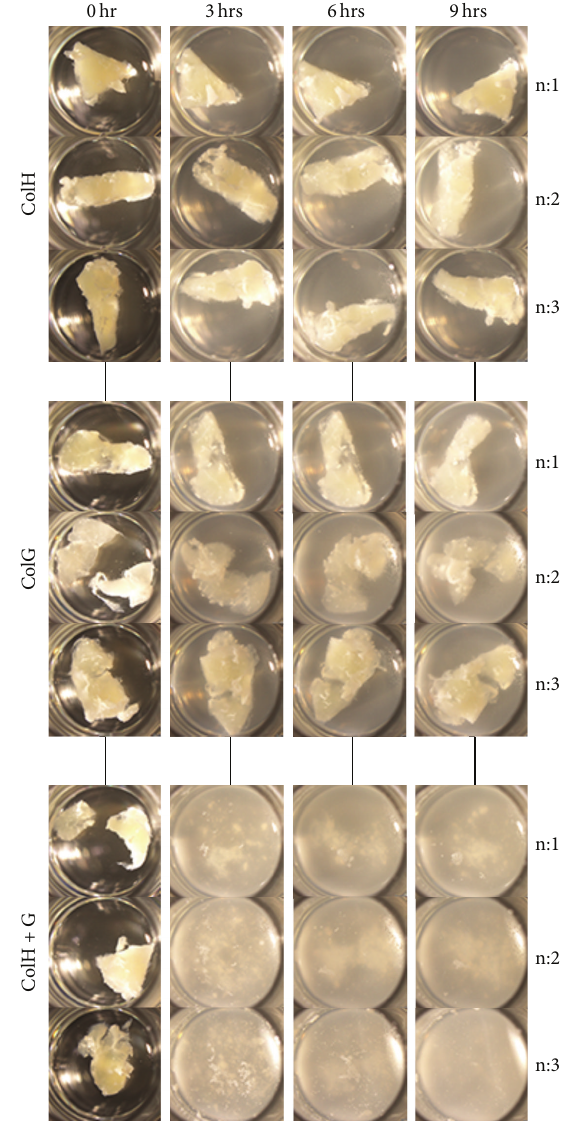
Figure 5: In vitro porcine pancreatic tissue digestions by proteases. The digestions were observed at 0, 3, 6, and 9h. Each digestion was conducted in triplicate.